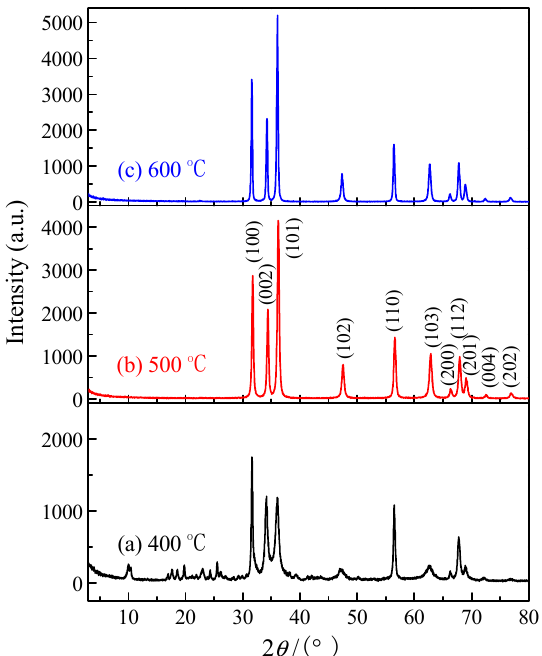
Figure 6. XRD patterns obtained by the calcination of [Zn 2 (btca)(H 2 O) 4 ] at different temperatures, ( a ) 400 °C, ( b ) 500 °C, and ( c ) 600 °C.